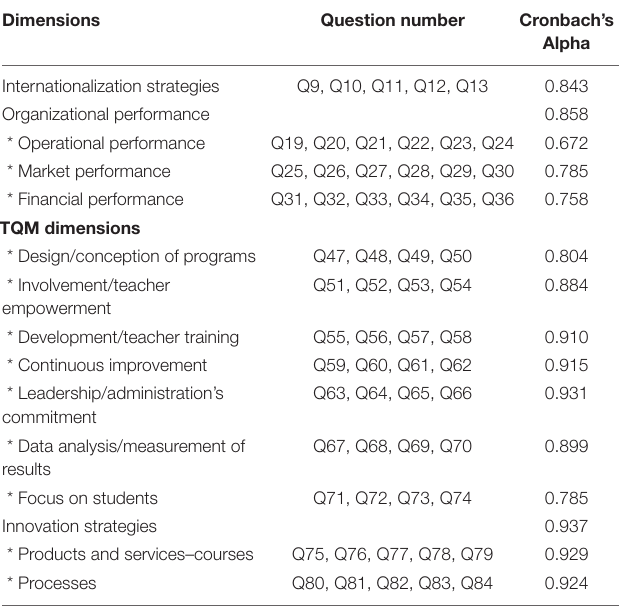
TABLE 1 | Cronbach’s Alpha.